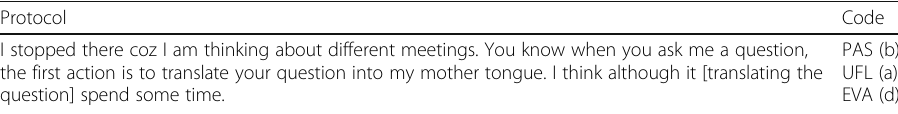
Table 1 Coding procedure and codes used